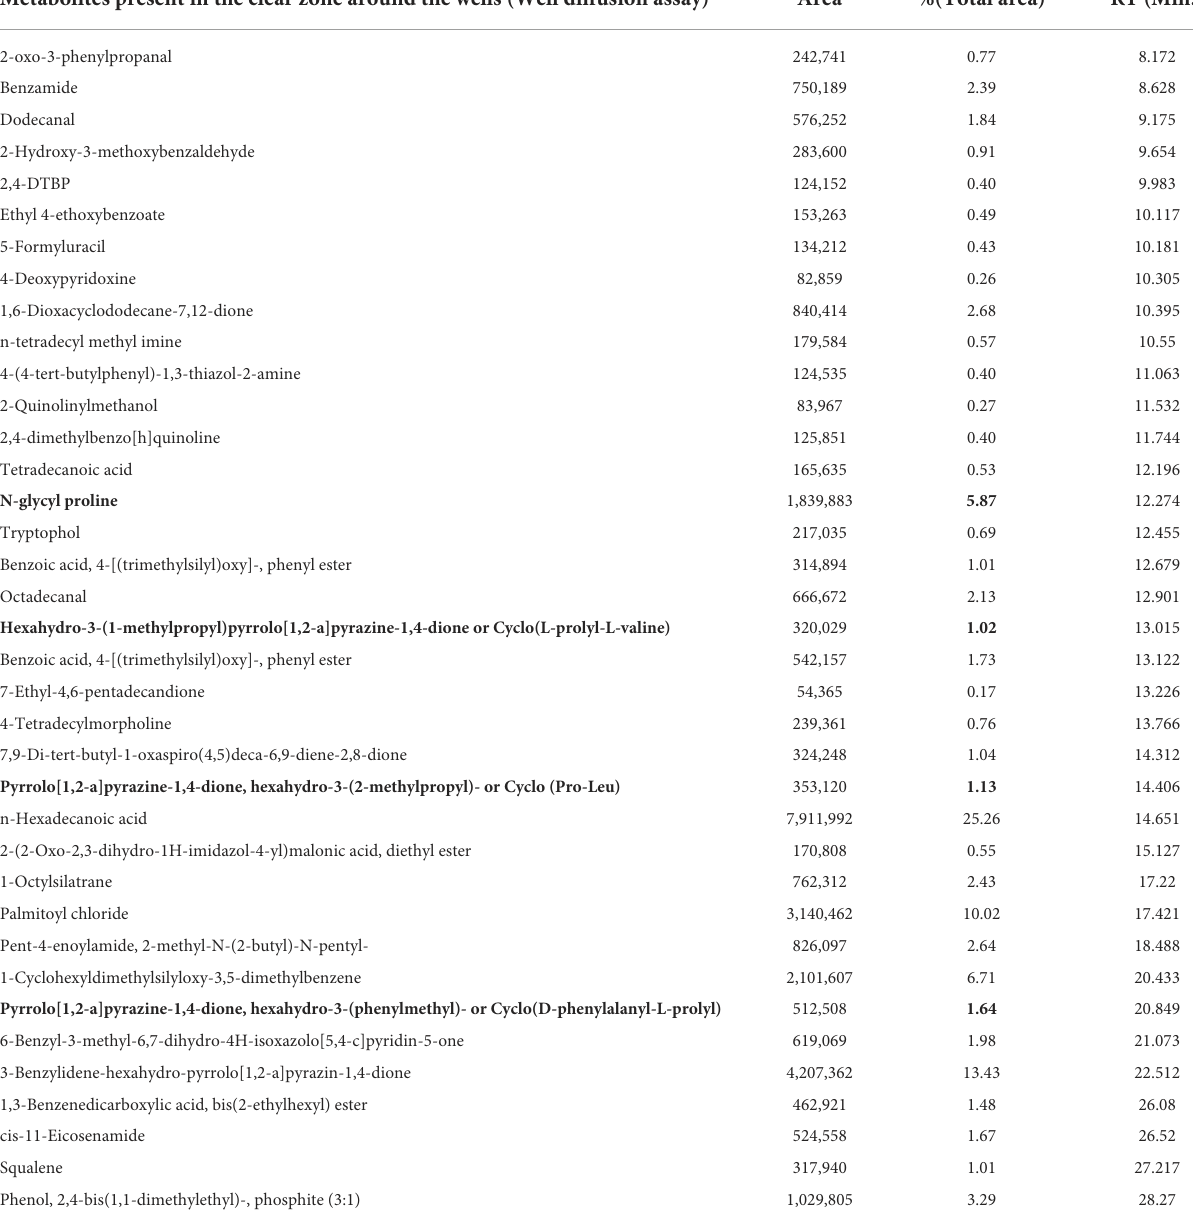
TABLE 4 Metabolite present in the clear zone around the well (Zone of diffused metabolites). Metabolites present in the clear zone around the wells (Well diffusion